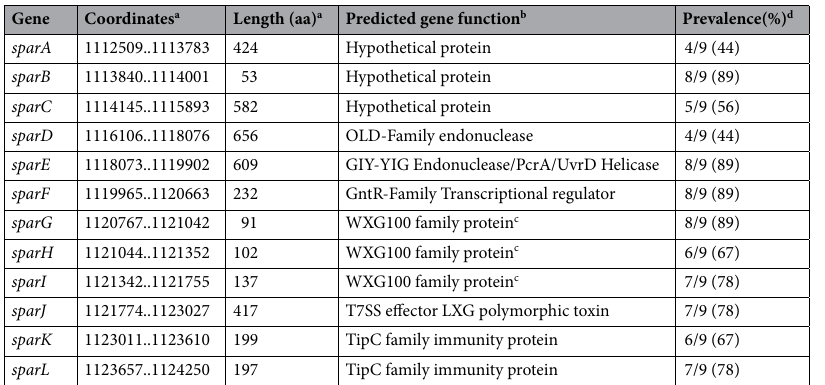
Figure 1. SPAR genetic organization and expression. ( A ) The SPAR locus. Genes encoding proteins with homology to proteins of known functions or containing characteristics of certain protein families are colored in blue, while genes encoding hypothetical proteins of unknown function are colored in gray. Comparable regions in TX20005 and ATCC 43143 are represented with genetic coordinates. ( B ) RT-PCR. cDNA synthesized from RNA extracted from HT29 cells co-cultured with TX20005 and the colonic tissues of three mice that had been orally gavaged with TX20005 were used as a template for the RT-PCR. cDNA from HT29 cells only and from mice orally gavaged with saline were used as controls to show the specificity of the PCR primers. RNA samples that had not been treated with reverse transcriptase (RT) were used as controls to show the lack of DNA contamination. Gene Coordinates